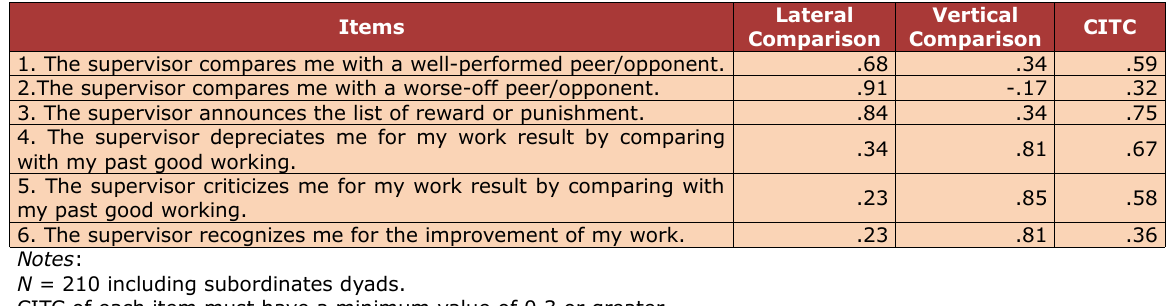
Table 1. Factor structure and loadings of lateral comparison and vertical comparison